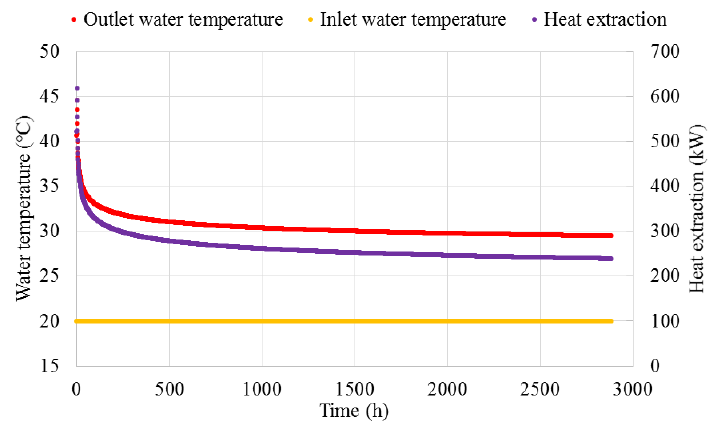
Figure 9. Continuous heat transfer performance of DBHEs in a heating